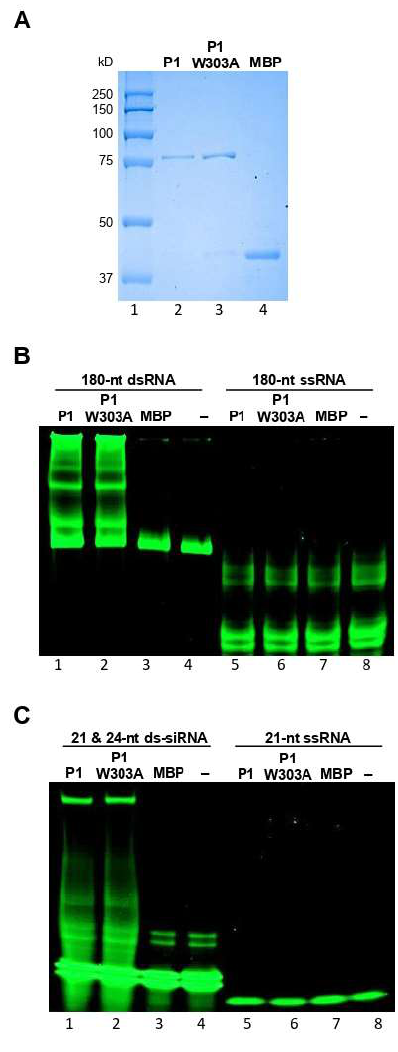
Figure 2. WSMV P1 interacts with dsRNA with no size specificity. ( A ) SDS-PAGE showing